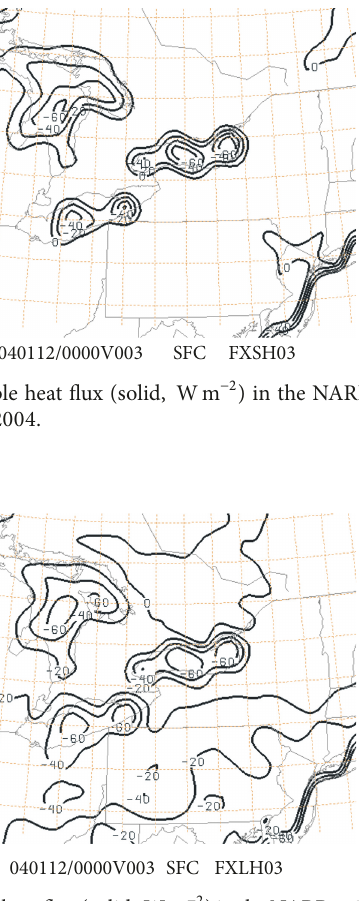
Figure12:Latentheatflux(solid, Wm −2 )intheNARRat0300UTC 12 January 2004.